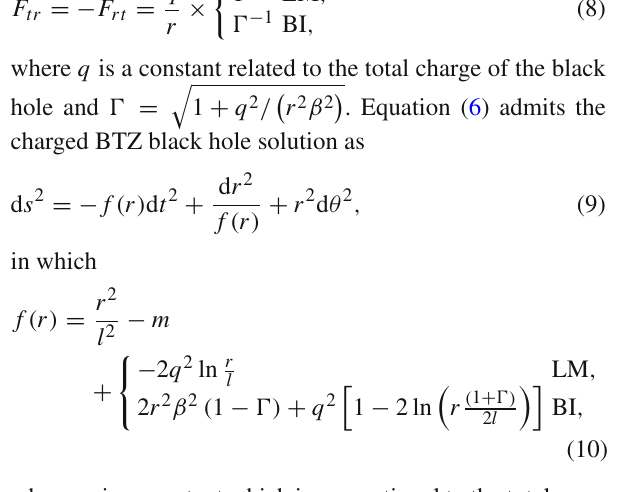
we have an equation relating q ext and m